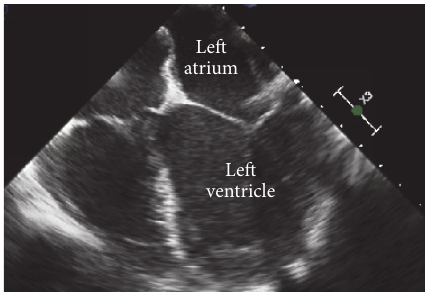
Figure 4: Transesophageal echocardiogram (TEE) image showing a preserved mitral valve after surgery resection of the CPFE.